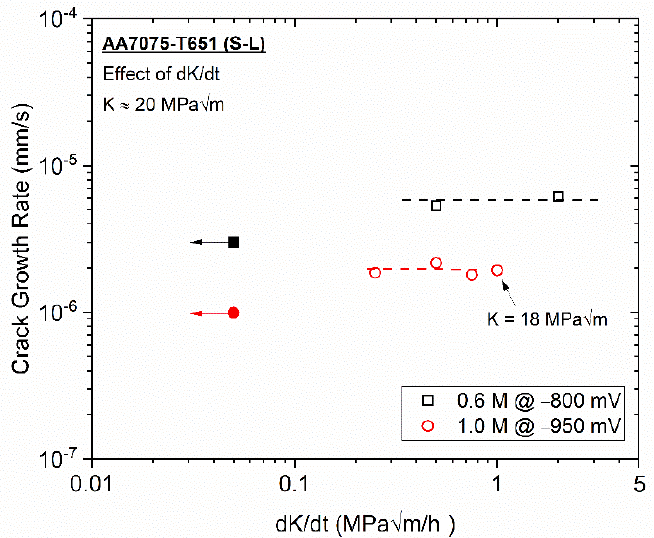
Figure 5. Effect of dK/dt on measured crack growth rate for AA7075-T651 immersed in 0.6 M NaCl at an applied potential of − 800 mV SCE (black squares) and 1.0 M NaCl at an applied potential of − 950 mV SCE (red circles at K = 20 MPa √ m). The closed symbols correspond to growth rates measured under static K conditions.